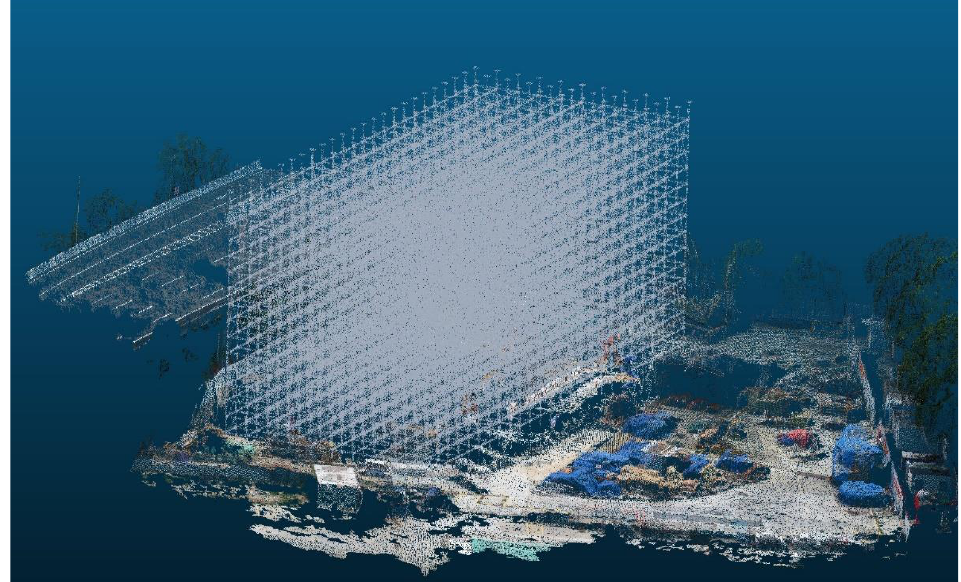
Figure 14. Image-based model of the high formwork.